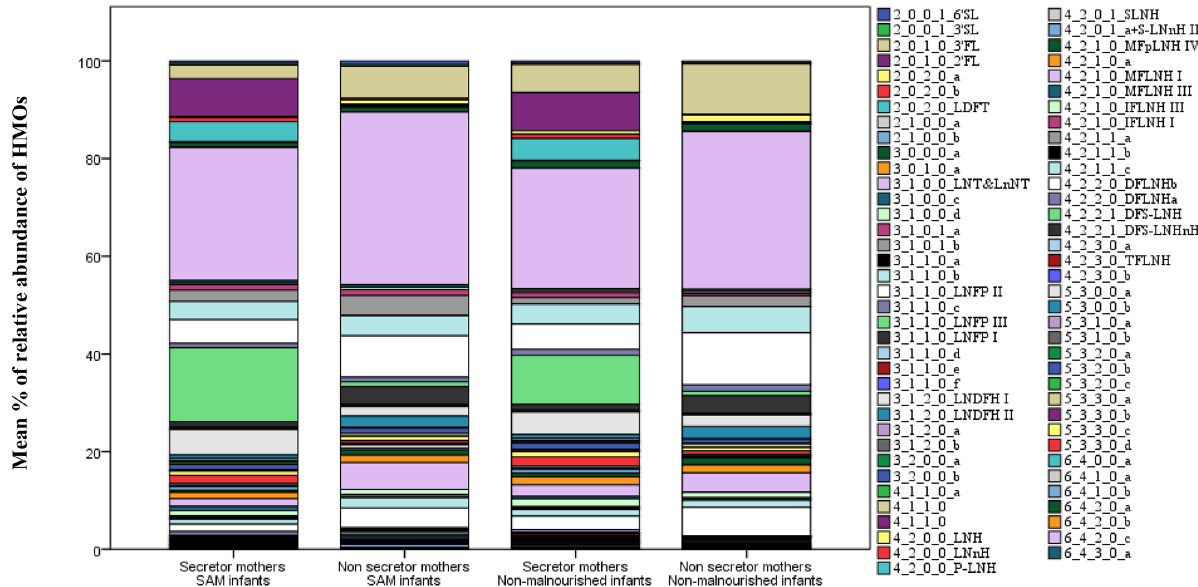
Figure 1. Distribution of different HMOs in mothers of different secretor status and having infants with different nutritional status. [6 ′ SL, 6 ′ -Sialyllactose; 3 ′ SL, 3 ′ -Sialyllactose; 3 ′ FL, 3 ′ -Fucosyllactose; 2 ′ FL, 2 ′ -Fucosyllactose; LDFT, lactodifucosyllactose; LNT&LnNT, lacto-N-tetraose& lacto-N-neotetraose; LNFP II, Lacto-N-fucosylpentose-II; LNFP III, Lacto-N-fucosylpentose-III; LNFP I, Lacto-N-fucosylpentose-I; LNDFH I,lacto-N-difucosylhexose-I; LNDFH II, lacto-N-difucosylhexose-II; LNH, lacto-N-hexaose; LNnH, lacto-N-neohexaose; MFLNH I, monofucosyllacto-N-hexaose I; MFLNH III, monofucosyllacto-N-hexaose III; IFLNH III, isomer 3 fucosyl-paralacto-Nhexaose; IFLNH I, isomer 1 fucosyl-paralacto-N-hexaose; P-LNH, para-lacto-N-hexaose; SLNH, Monosialyllacto-N-hexaose; a+S-LNnH II, No literature name + sialyllacto- N-neohexaose II; MFpLNH IV, Monofucosyl-paralacto-N-hexaose; DFLNHb, Difucosyllacto-Nhexaose b;